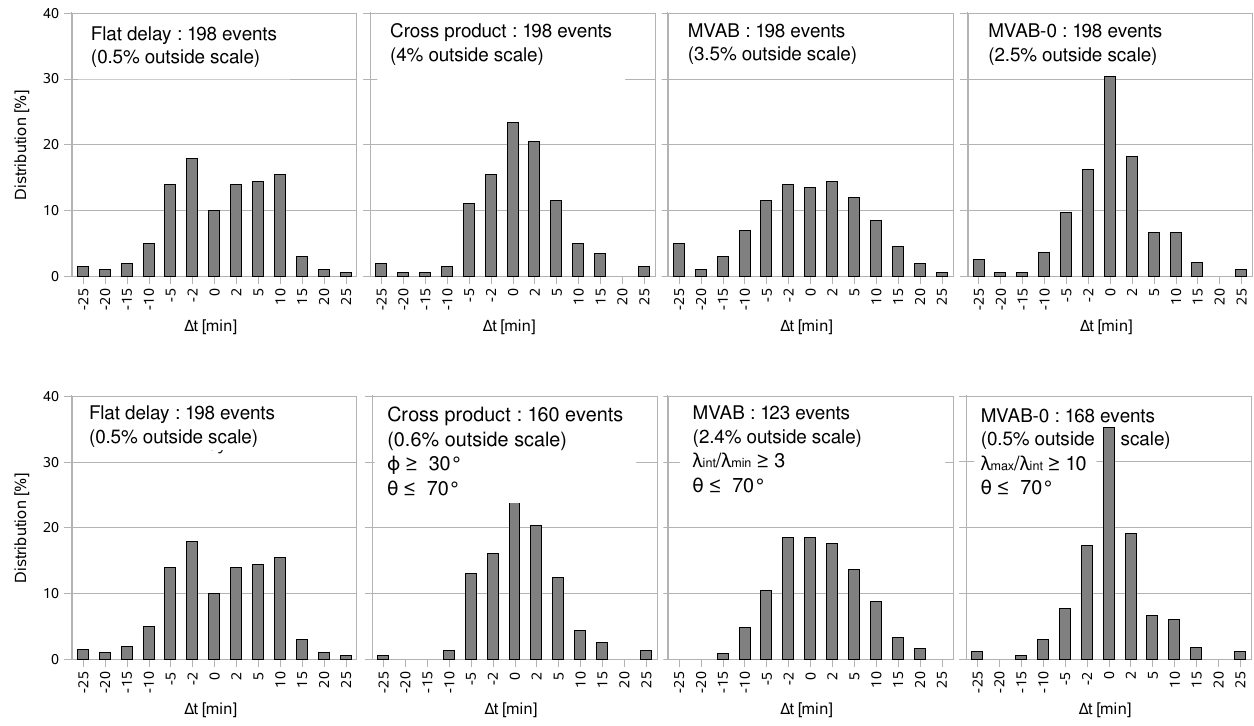
Fig. 3. Distributions of timing errors for each of the four tested methods. Top panels: results from the full data set, containing 198 events. Bottom panels: results from the filtered data set, i.e. events not satisfying the quality criteria described in Sect. 3.3 have been removed. The horizontal axes indicate the time differences 1t = t model − t observed for each method, and the vertical axes, common to all panels in that row, show the relative distribution within that 1t range. Note that the horizontal axes are non-linear; the center bin (marked 0) means ± 0–2min, the next bin ± 2–5min, thereafter ± 5–10min etc. Also, the horizontal scale is limited to ± 25min, but a few events from each method had larger discrepancies. These are indicated in each panel as (% outside scale).